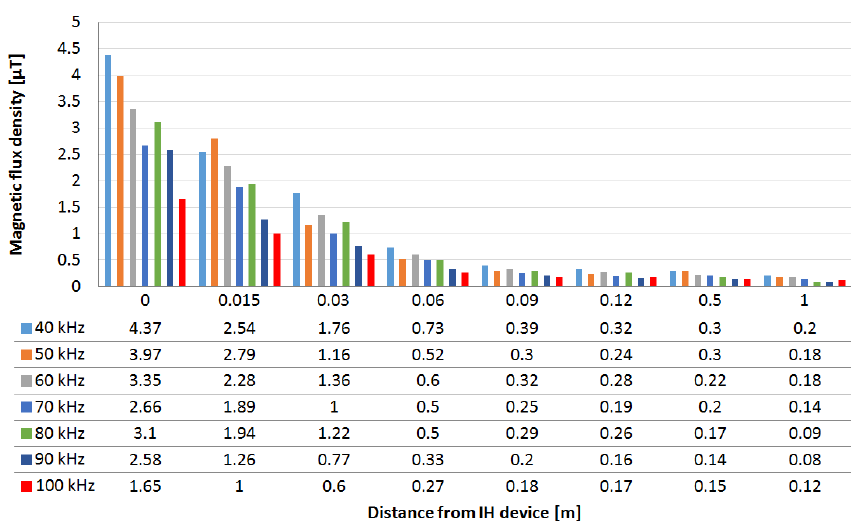
Figure 18. Magnetic flux density vs. distance from the IH radiator for various operating